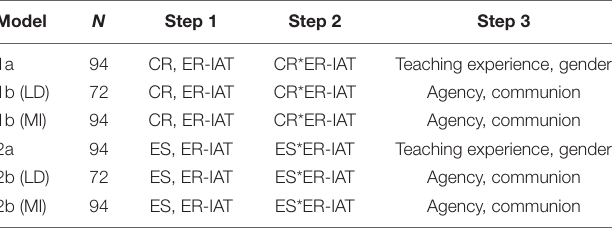
TABLE 3 | Overview of conducted hierarchical multiple regression